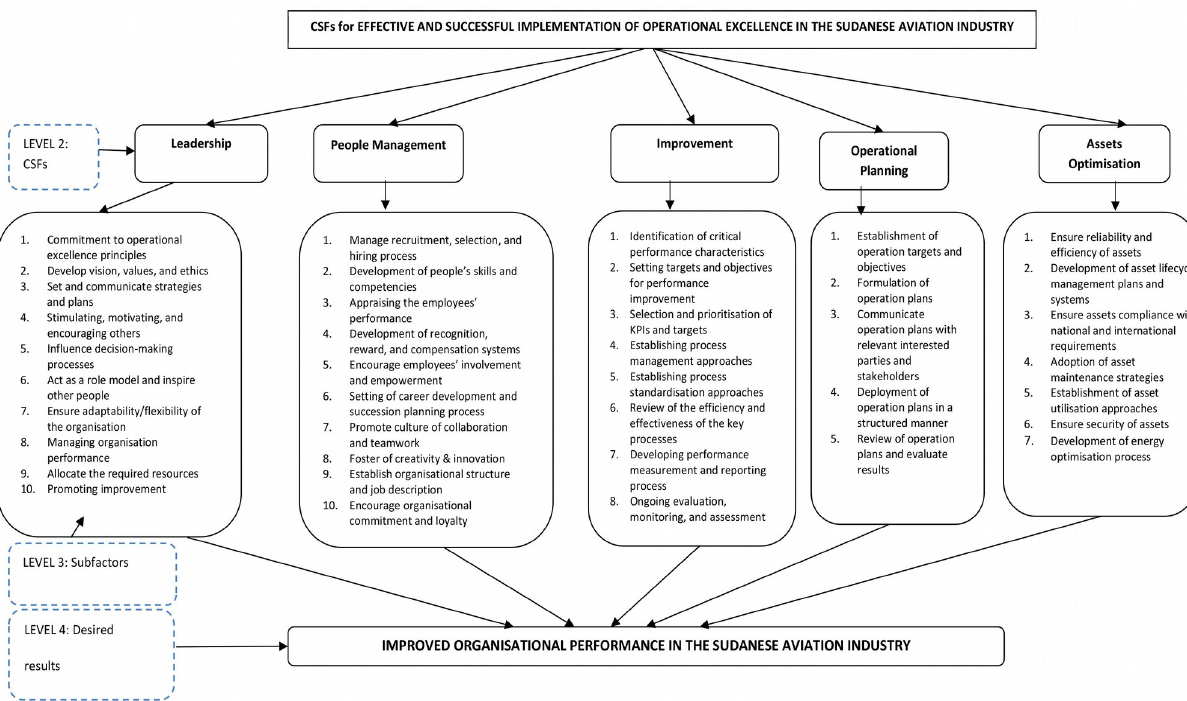
Figure 2. Proposed AHP Model for OE in the Sudanese